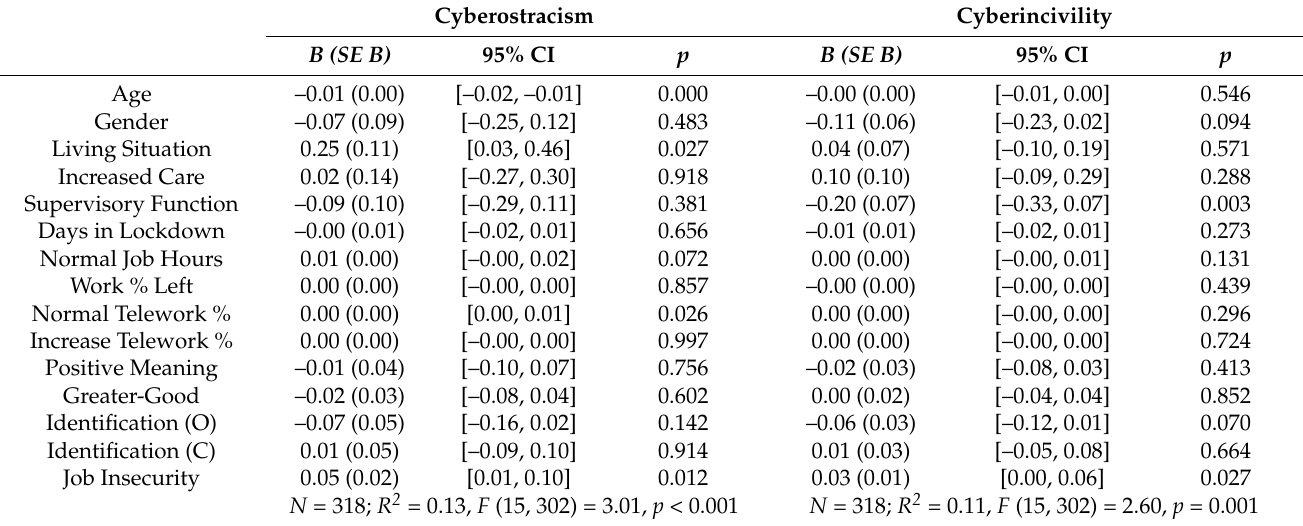
Table 8. Multiple regression analysis of work perceptions on cyberostracism and